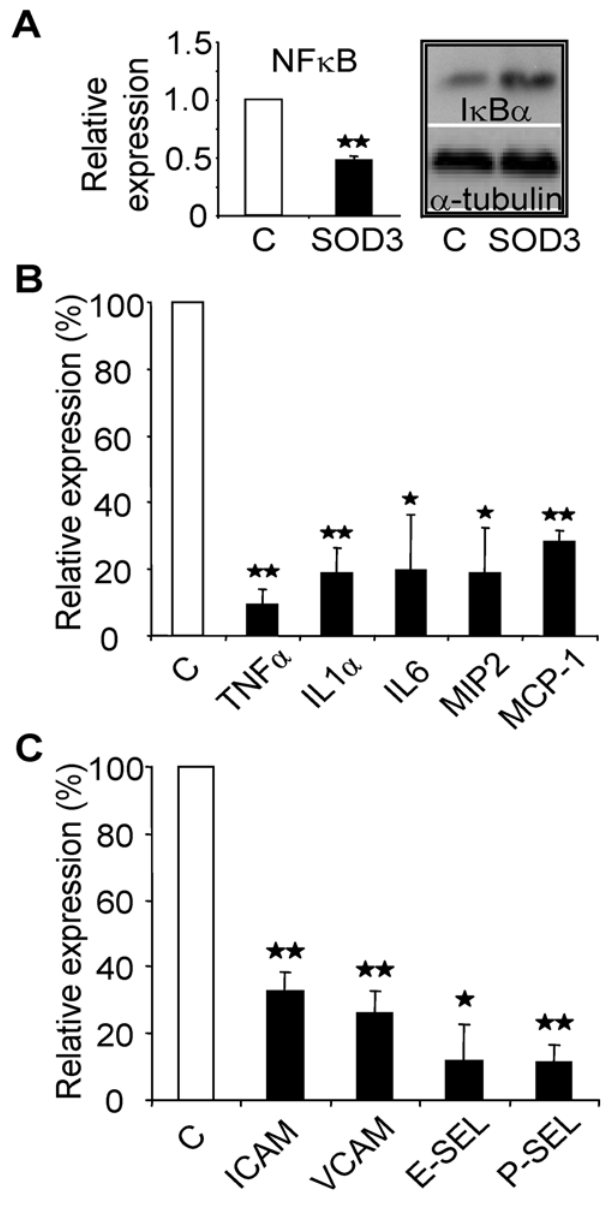
Figure 5. SOD3-mediated reduction in activity of inflammatory mediators. Open bars represent LacZ tissue and black bars represent SOD3 animals. (a) Luciferase assay shows 50% reduction in NF- k B activity in vitro , and western blot analysis shows increased I k B a expression. (b) Quantitative RT-PCR analysis for cytokines and chemokines. SOD3 overexpression derived reduced expression of TNF a , IL-1 a , IL-6, MCP-1, and MIP2 in injured tissue. (b) Analysis of ICAM, VCAM, P-selectin, and E-selectin expression. Expression of inflammatory adhesion molecules was significantly reduced in SOD3 muscle.